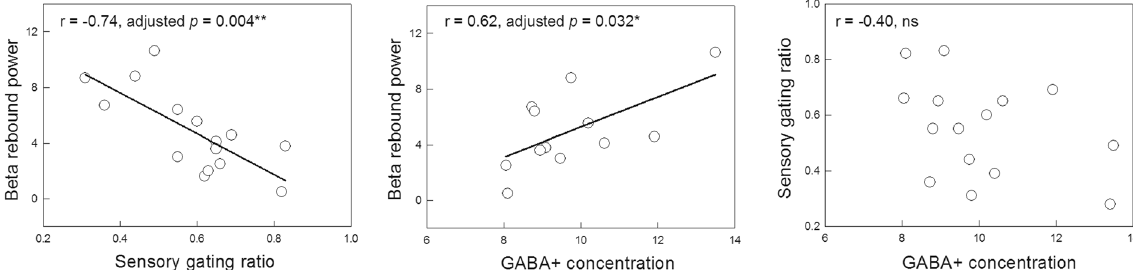
Figure 4. The SI SG ratio was significantly correlated with the MI beta rebound power. The GABA + levels in the sensorimotor cortex modulated the variability of the MI beta rebound power, but not the beta peak frequency. No association was found between GABA + concentration and the SI SG